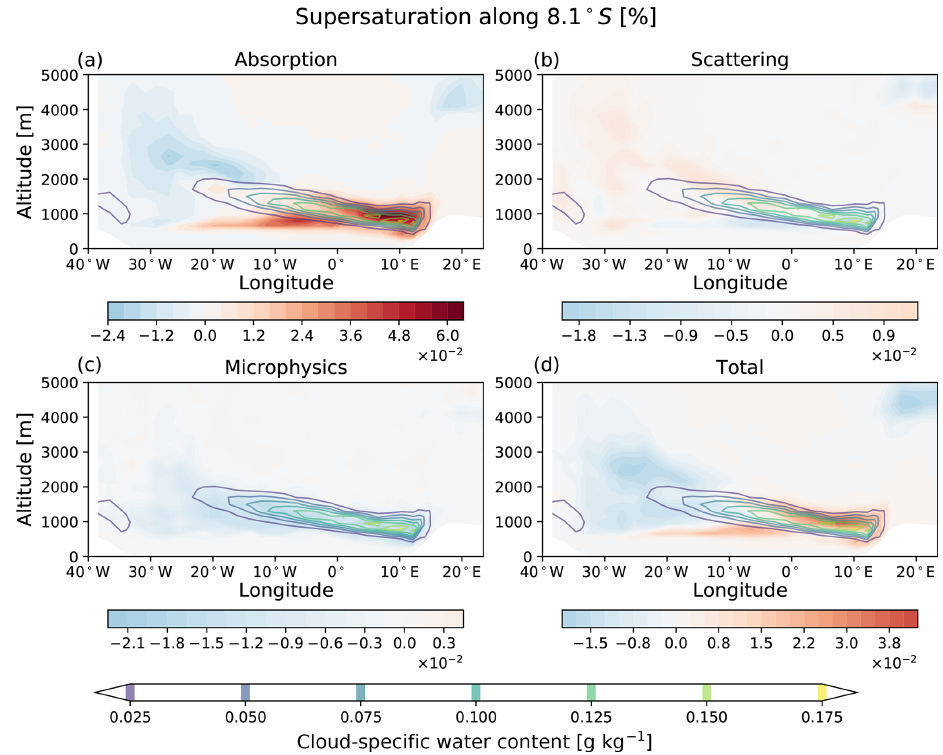
Figure 5. UKESM1-simulated mean vertical profiles of BBA effects on supersaturation along the latitude of Ascension Island (see Fig. 3a) during July and August 2016–2017: (a) absorption, (b) scattering, (c) microphysical, and (d) total. The contour lines are the baseline cloud- specific water content. The same colour map scale is used in each plot to facilitate comparison, but the colour map ranges differ in each plot, corresponding to the maximum and minimum variation of supersaturation in